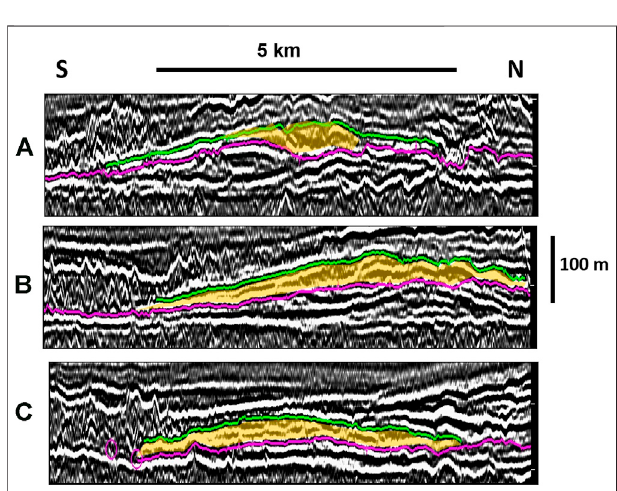
FIGURE 9 | Cross sections through LE3 from a 3D re fl ection seismic volume. See Figure 8 for locations. The green and purple horizons indicate the top and base respectively of LE3 (highlighted in yellow). (A) Seismic section through the feeder channel complex of LE3. (B) Seismic section through the proximal part of LE3. (C) Seismic section through the distal part of